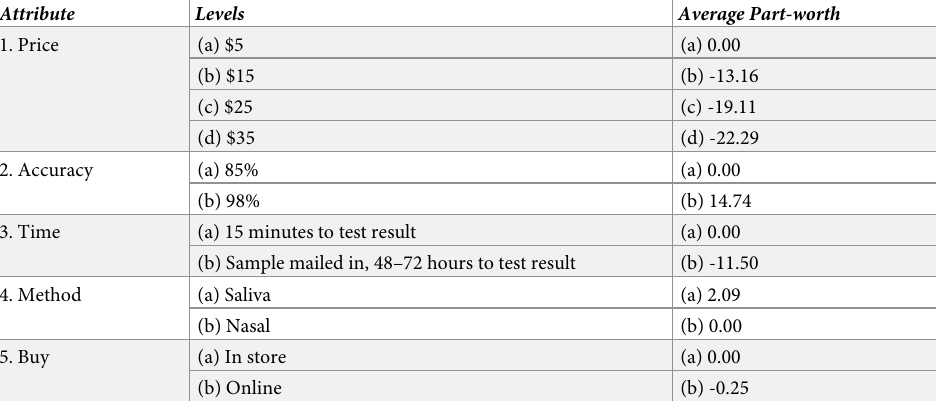
Table 4. Average part-worth values for attribute